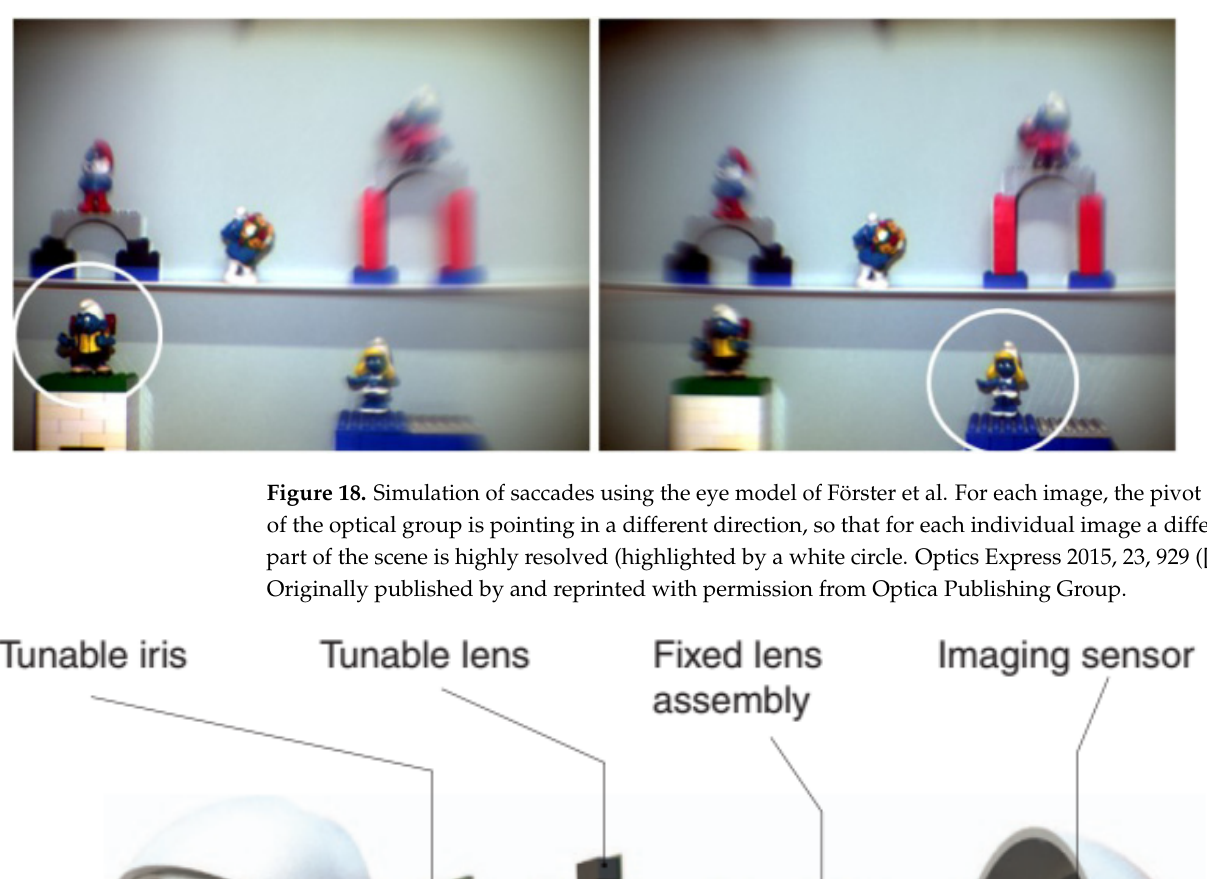
23 of 55 Figure 17. Sectional drawing of the model presented by Ackermann et al. Biomedical Optics Express 2013, 4, 220 ([45]). Originally published by and reprinted with permission from Optica Publishing Group. Some recent eye models started to introduce modern features such as electronic con- trollable pupils and crystalline lenses. Some of such models were already presented above ([55,57,70]), but were not relevant enough for human vision applications. Relevant models are briefly described below. Liang et al. [51] developed a device based on the Gullstrand model [1], which con- sisted of a bionic cornea lens, a voice coil motor controlling a compression ring to com- press a bionic crystalline lens, a substrate, and a CCD sensor. By controlling the current of the voice coil motor, the displacement of the compression ring could alter the curvature radius of the bionic crystalline lens, thus adjusting the focal length of the whole system. Images with text were captured under different displacement loads. The object distance was adjusted to get a clear image on the CCD sensor and the back focal length was meas- ured from the CCD sensor plane to the lens frame surface facing the sensor. Förster et al. [54] created an artificial eye to model accommodation and gaze move- ment. It used an aspherical surface and diffractive optical element to model the cornea